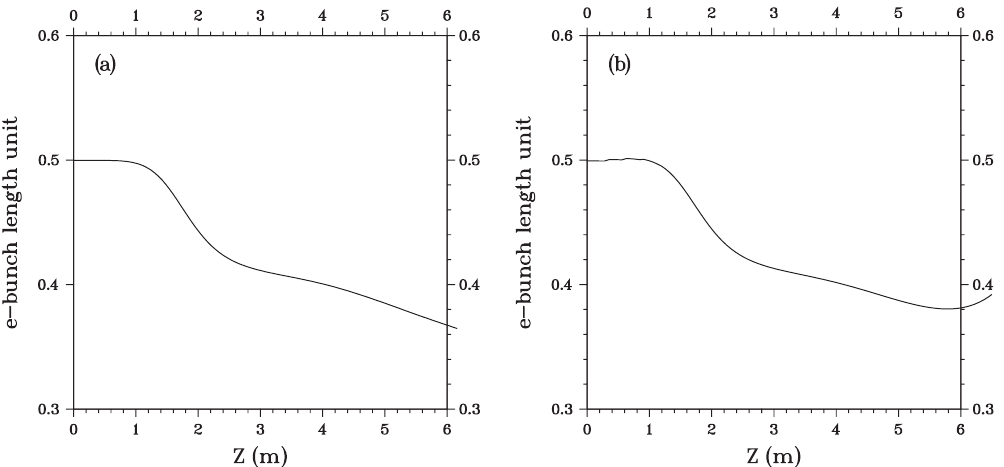
FIG. 3. Packet rms (cid:3) ( (cid:8) units) vs the undulator coordinate: (a) analytical computation; (b) PROMETEO numerical simulation. Same z parameters as Fig. 1.